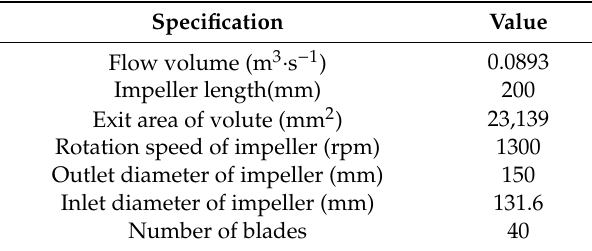
Figure 1. Three-dimensional model of the baseline centrifugal fan: ( a ) whole fan; ( b ) impeller. Table 1. Specifications for the centrifugal fan.